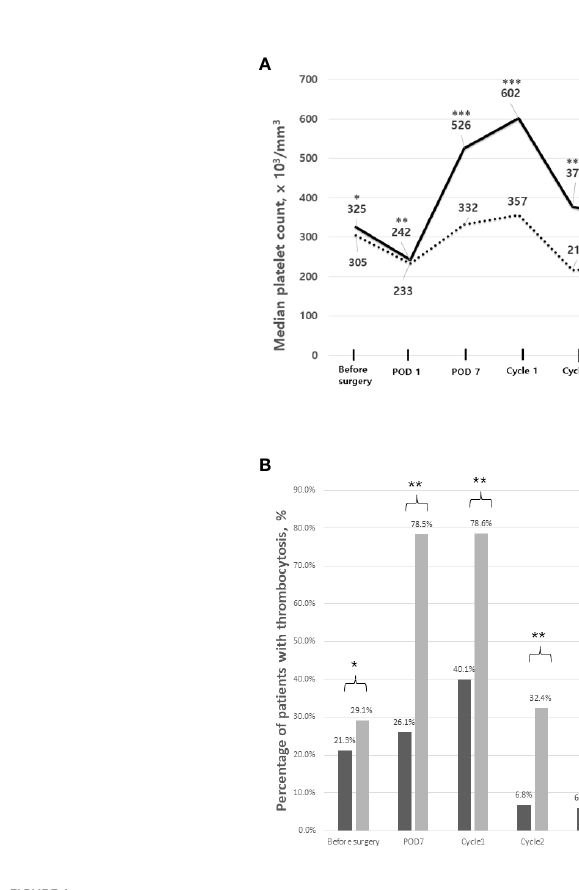
FIGURE 1 Trends of platelet counts and thrombocytosis during treatment. (A) Median platelet count during perioperative period and during adjuvant chemotherapy. (B) Percentage of patients with thrombocytosis during perioperative period and during adjuvant chemotherapy. Cycle 1 represents a day of blood test for the fi rst cycle of adjuvant chemotherapy. POD, postoperative